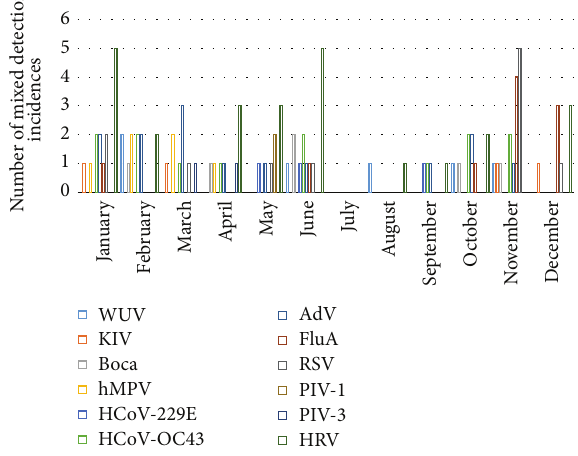
Figure 1: Monthly distribution of viral mixed detection.